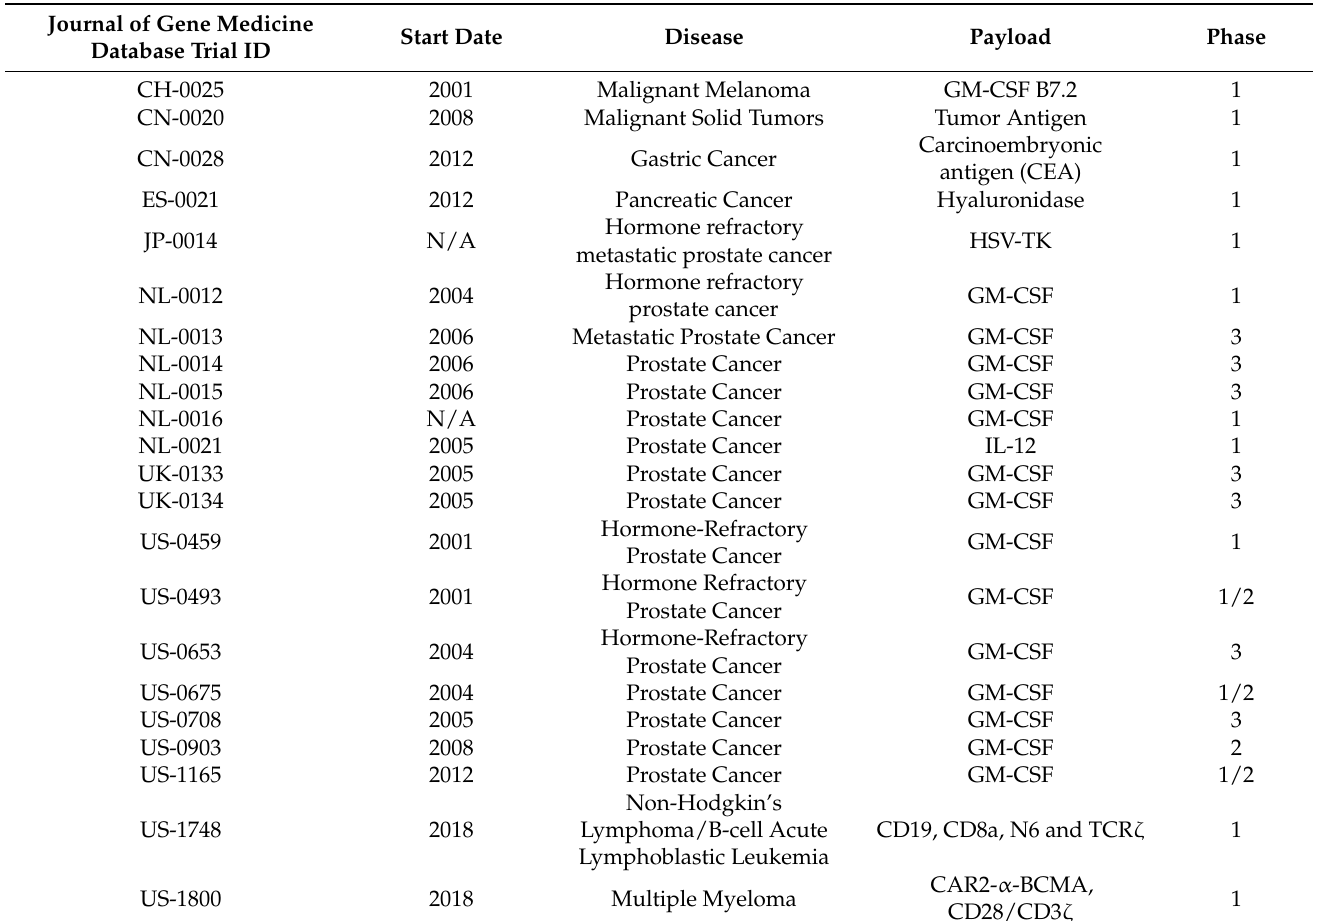
Table 1. Clinical Trials Employing Viral-based Vectors for Cancer Gene Therapy Treatment [23]. Database Accessed on 6 March